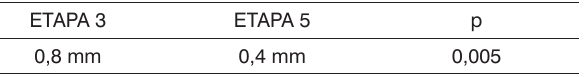
Tabela 5. Comparação das médias entre as etapas 3 (com o sis- tema; tesoura parada no centro; fio esticado) e 5 (com o sistema; tesoura no centro; fio afrouxado em 3